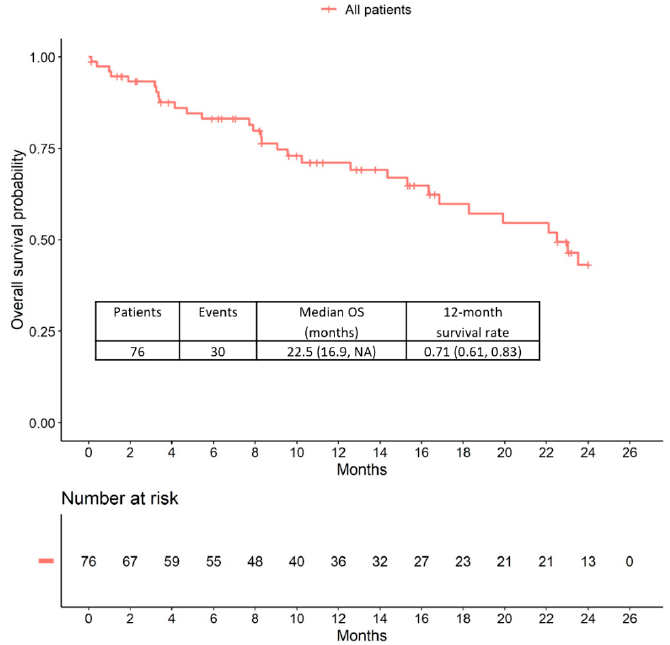
Figure 3. Overall survival (OS) in all patients receiving T-DM1 therapy.